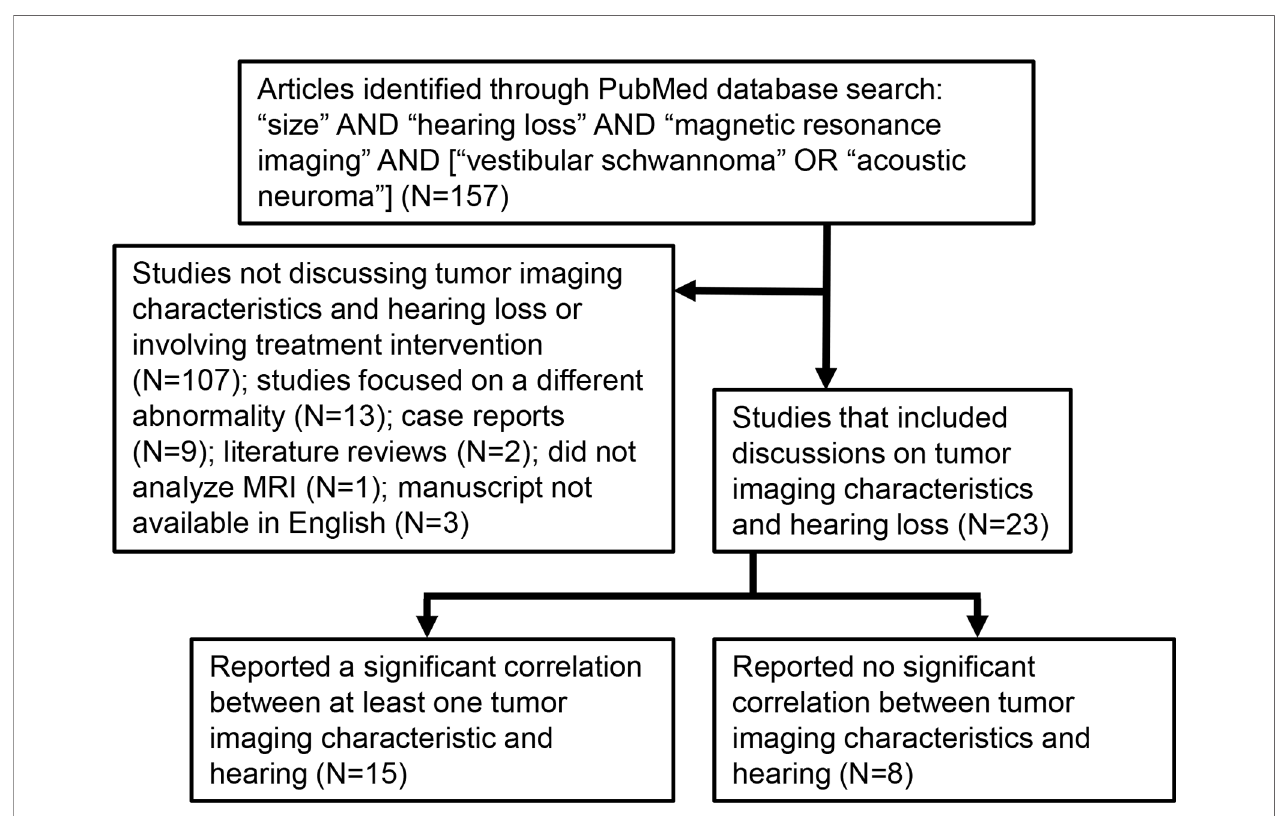
FIGURE 2 | Selection of articles through comprehensive literature review.